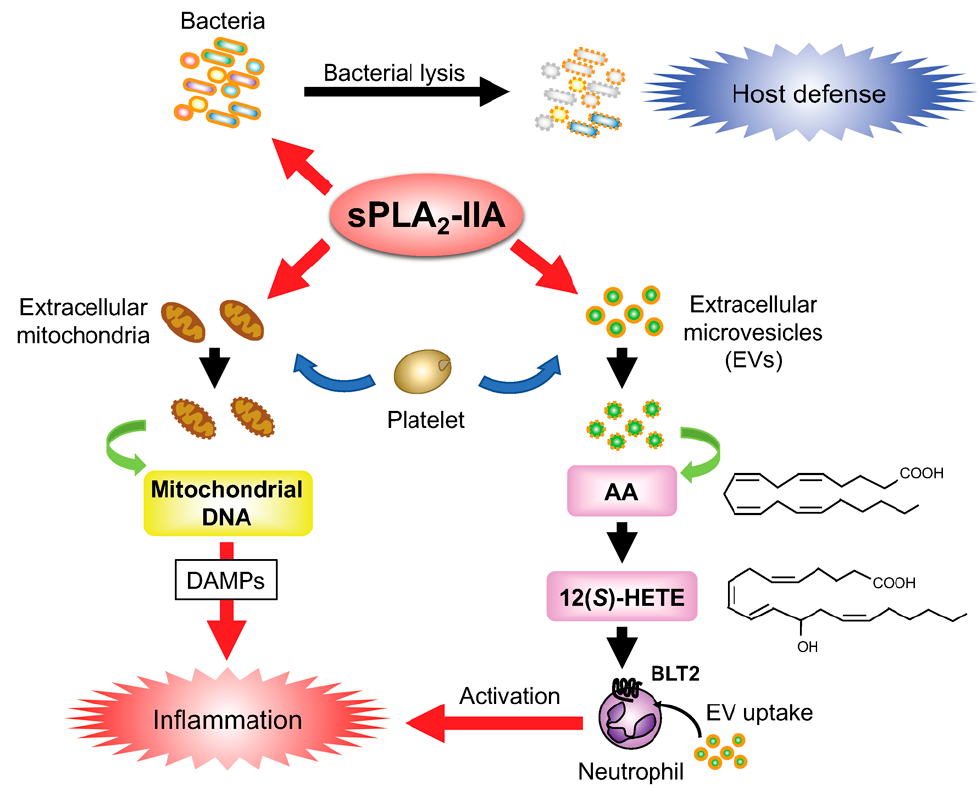
Figure 1. The roles of sPLA 2 -IIA in anti-bacterial defense by degrading bacterial membrane and in sterile inflammation by releasing pro-inflammatory eicosanoids from extracellular microvesicles (EVs) derived from inflammatory cells.